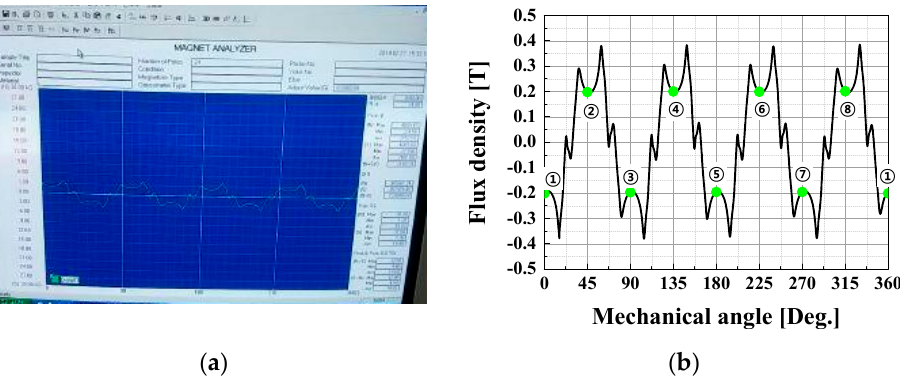
Figure 6. Measurement of waveform for the magnetic flux density on the rotor surface: ( a ) wave form of measurement equipment; ( b ) waveform of eight poles for the rotor.